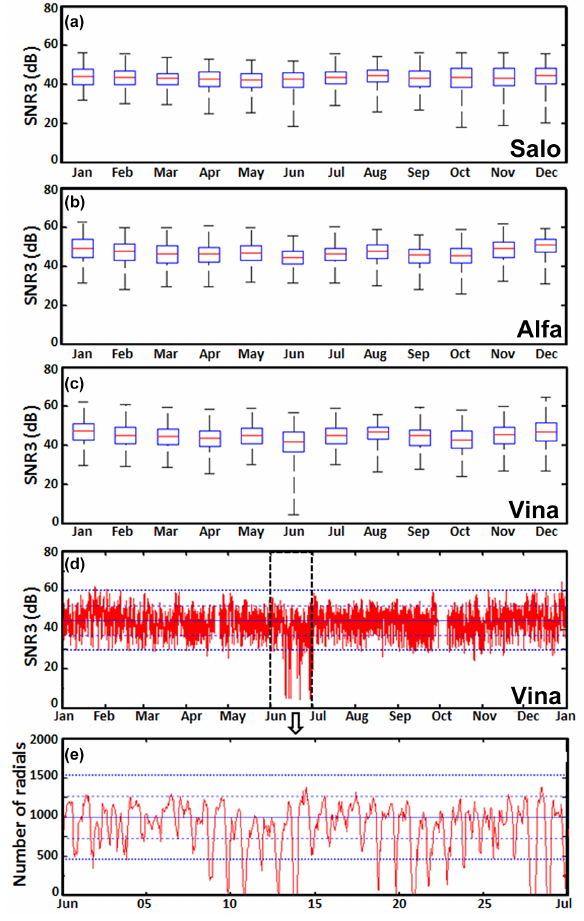
Figure 2. Annual quality control of Ebro delta radar sites, SALO (a) , ALFA (b) and VINA (c) , based on monthly boxplots of the signal-to-noise ratio at the monopole (SNR3) for 2014. In each box, the central mark is the median, the edges of the box are the 25th and 75th percentiles, and the whiskers extend to the most extreme data points. (d) Annual time series of hourly SNR3 values for the VINA site. (e) Monthly time series of hourly radial vectors provided by the VINA site during June 2014. The solid and dashed blue lines represent the mean and the standard deviation for the entire 2014, respectively. The bold blue dotted lines denote the thresholds of 2 standard deviations above/below the